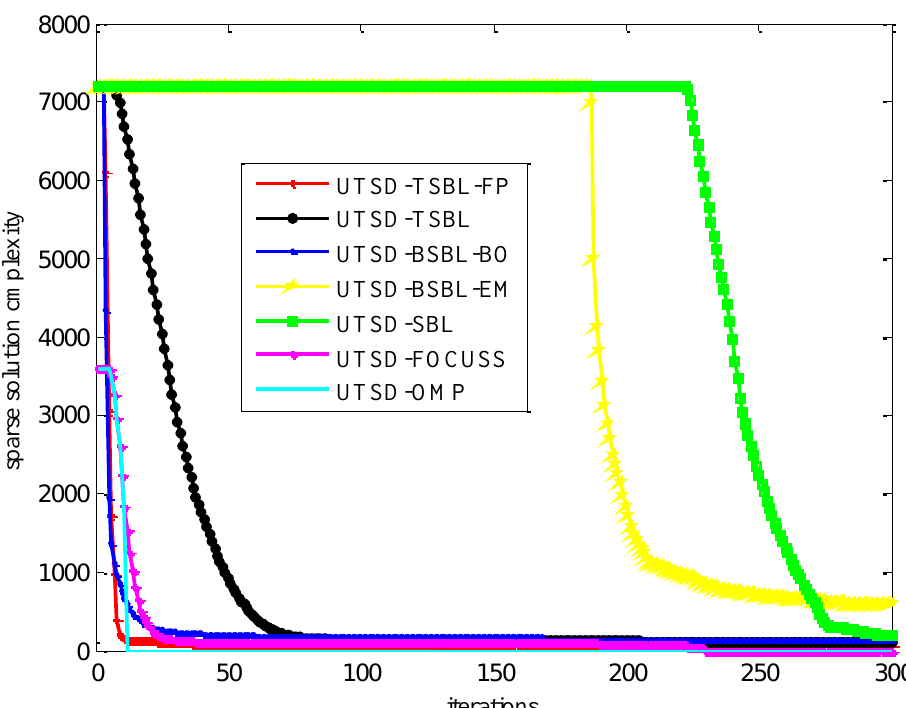
Figure 9. Running time comparison of different algorithms with UTSD.